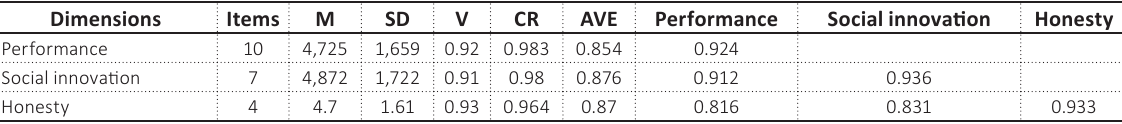
Table 4. Content validity, convergent, and discriminant validity